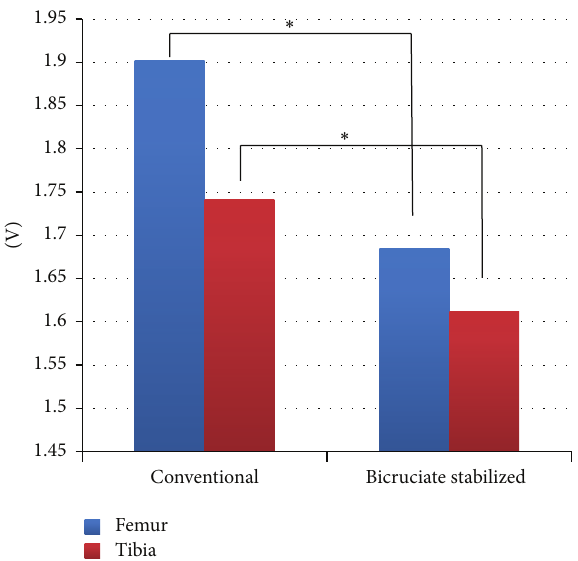
Figure 7: Acceleration of the conventional and bicruciate stabilized total knee arthroplasty. ∗ 𝑃 < 0.05 paired 𝑡